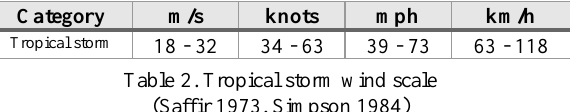
Table 2. Tropical storm wind scale